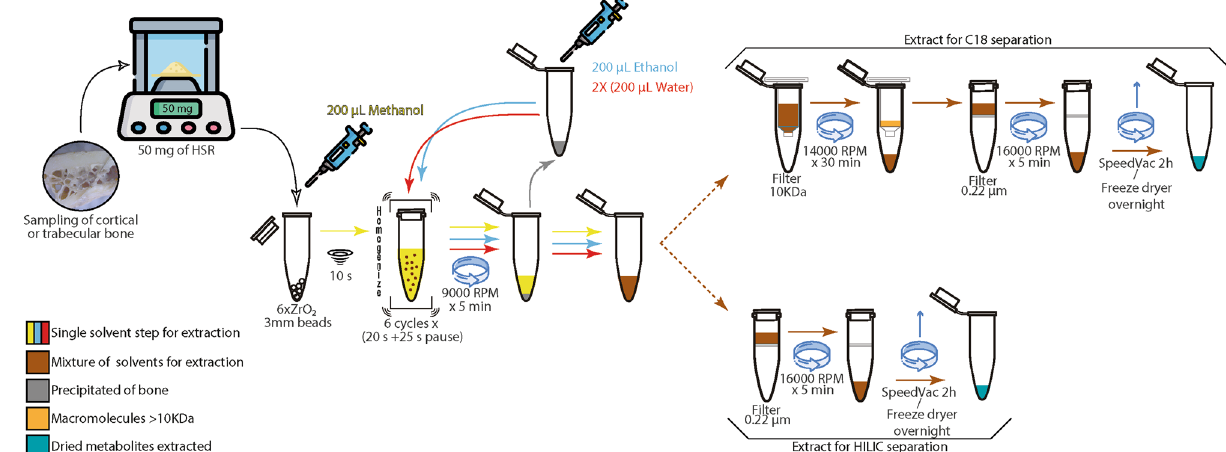
Figure 1. Detailed process for the liquid–solid extraction of polar and less polar/apolar metabolites from human skeletal remains (HSR) for liquid chromatographic separation through C18 and HILIC